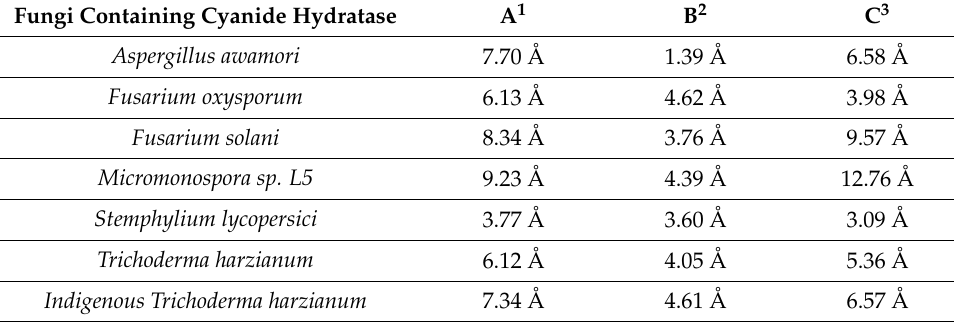
Table 3. The A, B, and C distances in different fungal strains. Fungi Containing Cyanide